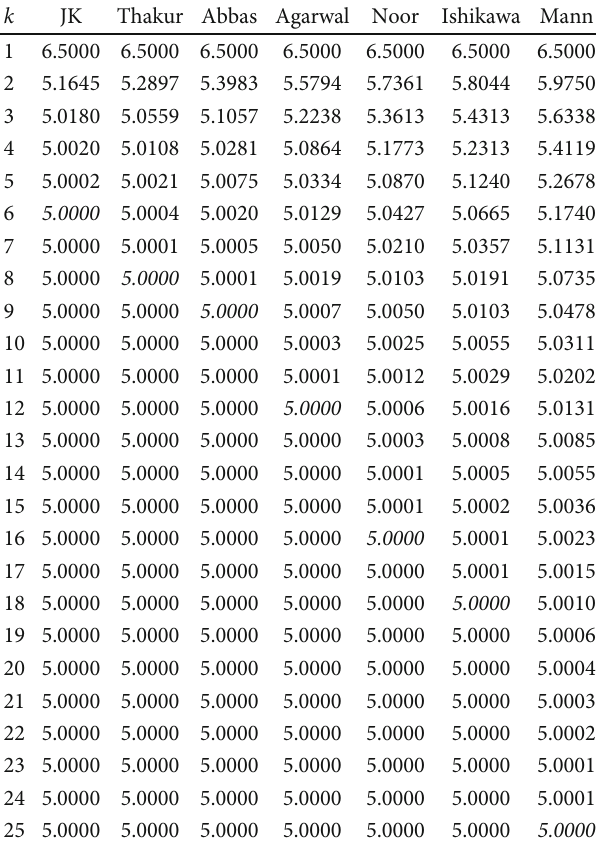
Table 1: Strong convergence comparison of JK (12), Thakur (11), Abbas (10), Agarwal (9), Noor (8), Ishikawa (7), and Mann (6) iterates for the self-map S in Example 13.